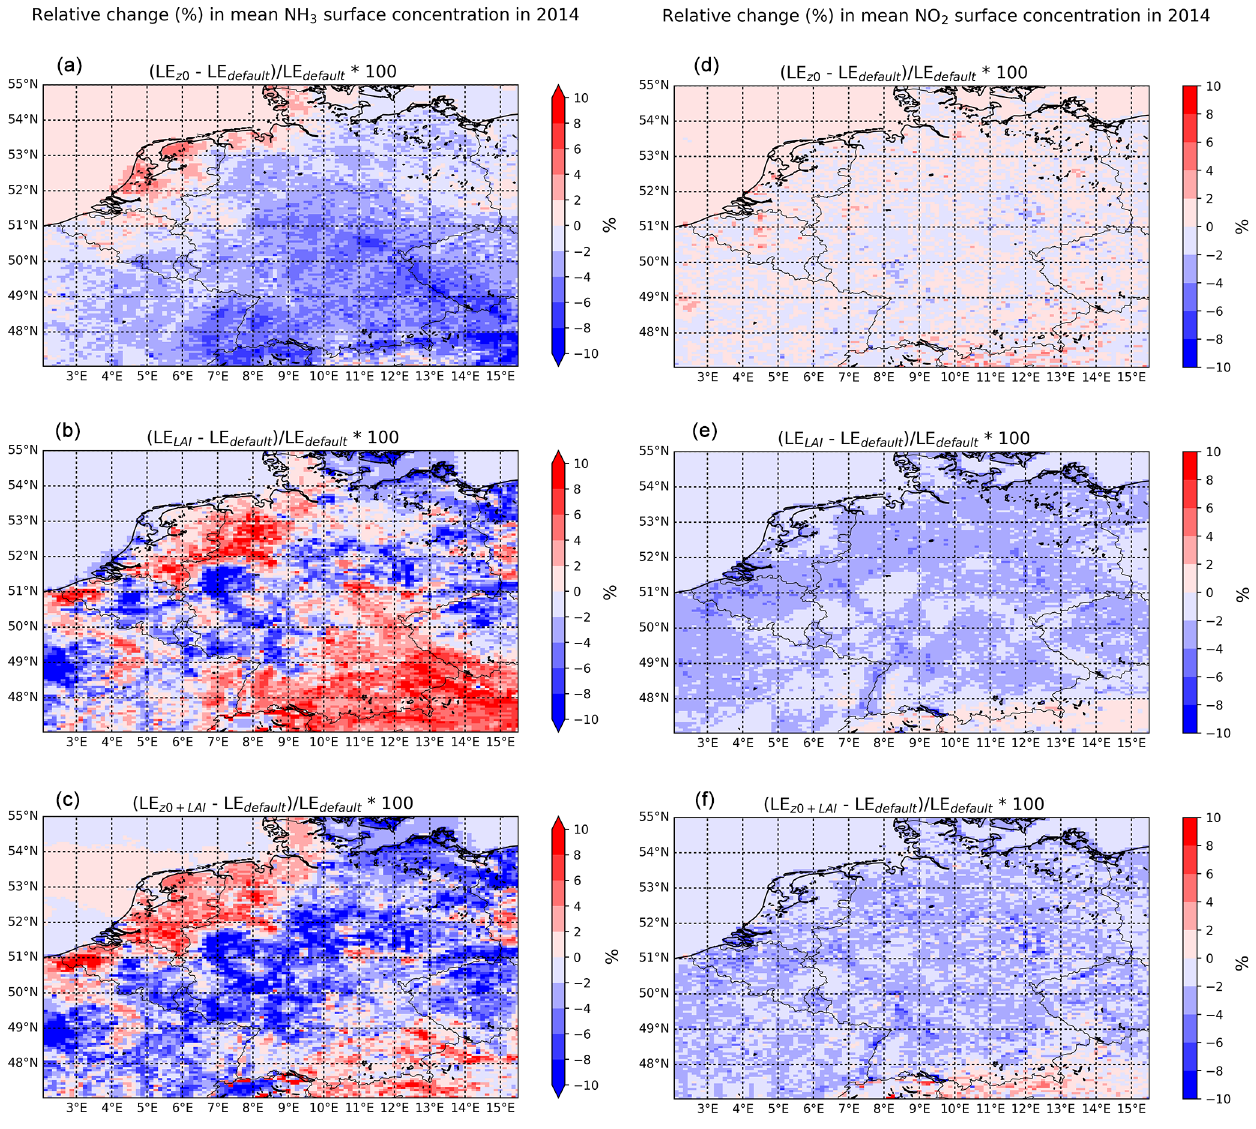
Figure 15. The relative change (%) in mean NH 3 (a, b, c) and NO 2 (d, e, f) surface concentration in 2014 for the different model runs relative to the default LOTOS-EUROS run. The first row indicates the changes related to the implementation of the updated z 0 values. The second row indicates the changes related to the implementation of the MODIS LAI values. The third row shows the combined effect of both these